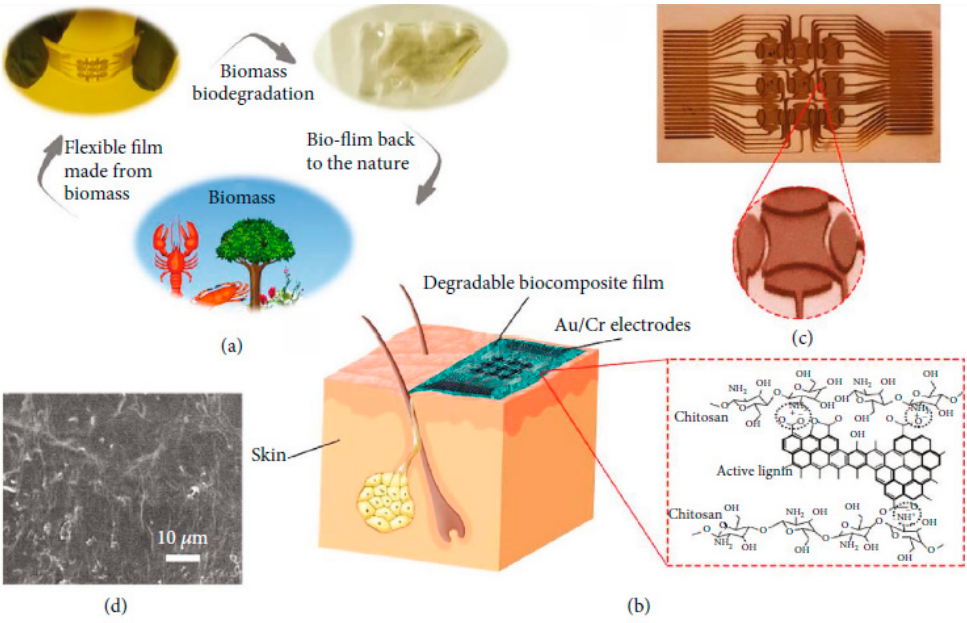
Figure 38. ( a ) Scheme of the life cycle for the degradable and natural sensor made of chitin, chitosan and lignin. ( b ) Details of the humidity sensor on skin, with the chemical structures of its constituents. ( c ) Micrograph of the electronic structure of the device. ( d ) SEM image of functionalized polysaccharide